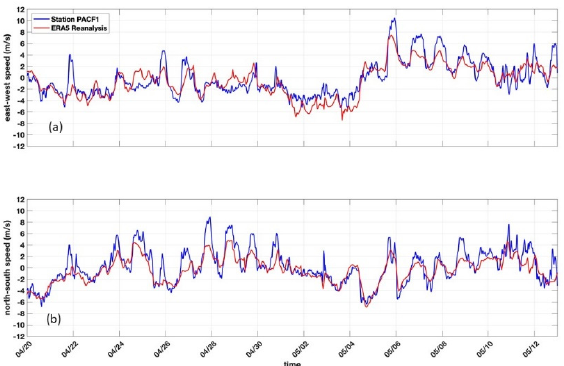
Figure 3. Surface ( a ) east-west wind component and ( b ) north-south wind component for the study area from the NOAA PACF1 buoy (blue curves) [18] and the ERA5 reanalysis data with 0.25° resolution from the European Centre for Medium-Range Weather Forecasts (ECMWF) (red curves) [19].